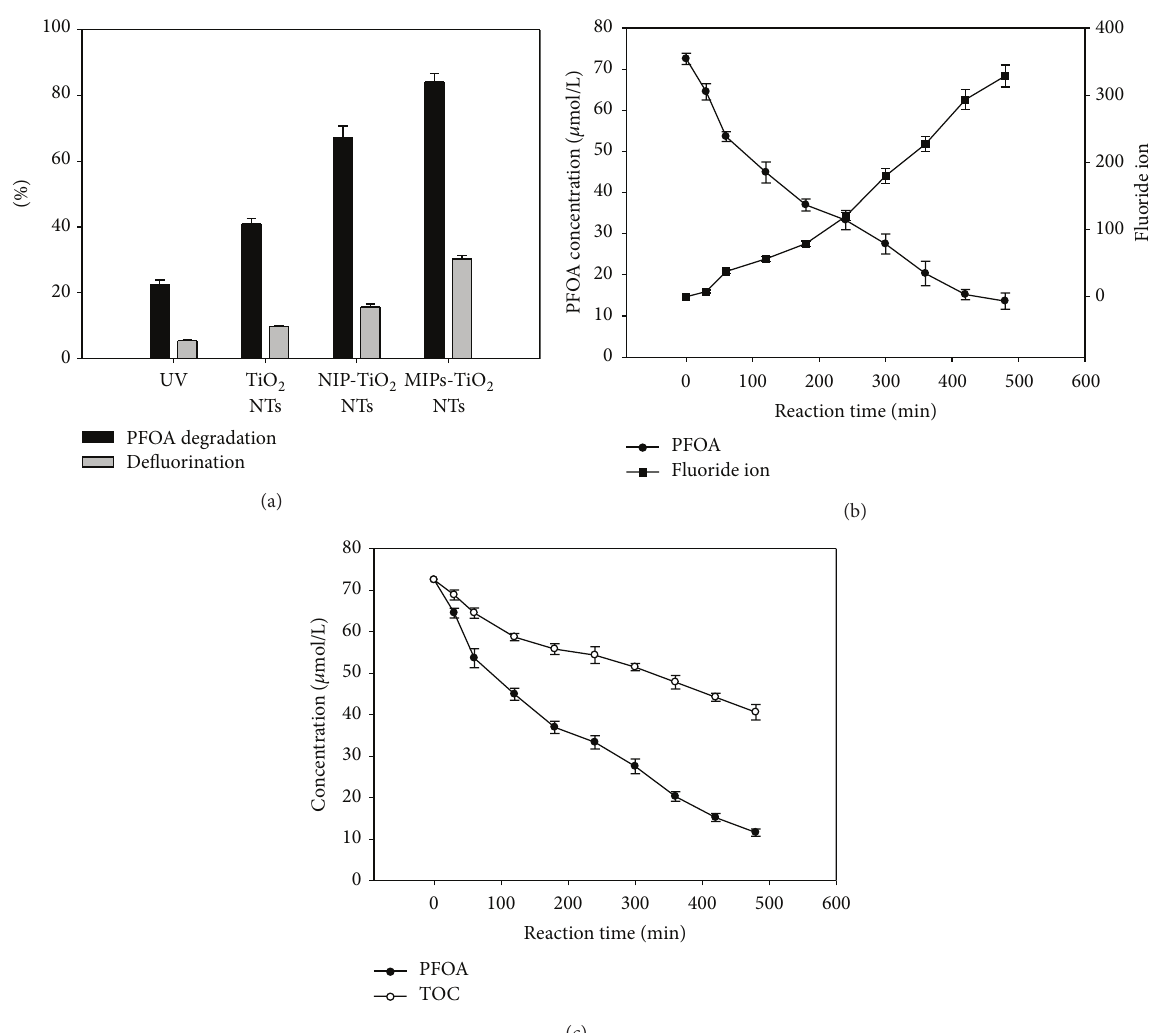
Figure 7: (a) PFOA degradation and defluorination towards UV photolysis, TiO 2 NTs, NIP-TiO 2 NTs, and MIP-TiO 2 NTs under 8 h irradiation; (b) release of fluoride ion responded to the change of PFOA concentration in the presence of MIP-TiO 2 NTs; (c) trends of total organic carbon responded to the change of PFOA concentration in the presence of MIP-TiO 2 NTs. Initial concentrations of PFOA and TOC were 72.5 𝜇 mol/L